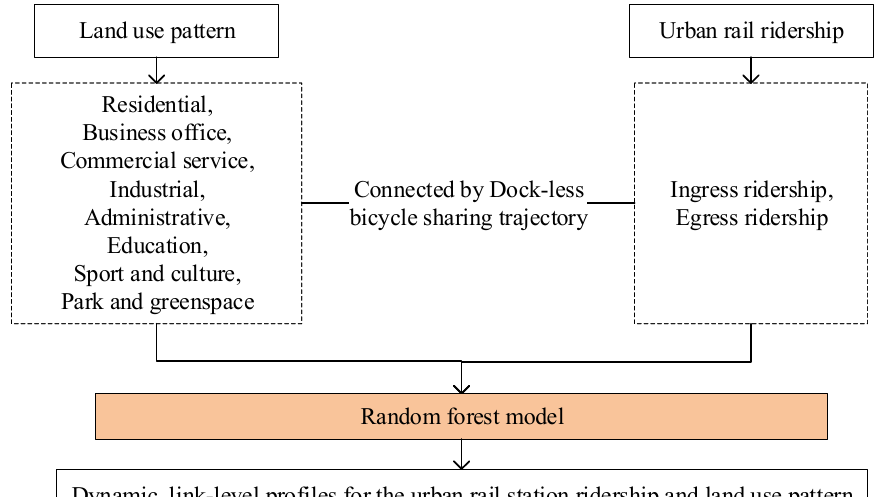
Figure 7. Flow diagram of random forest modeling methodology.